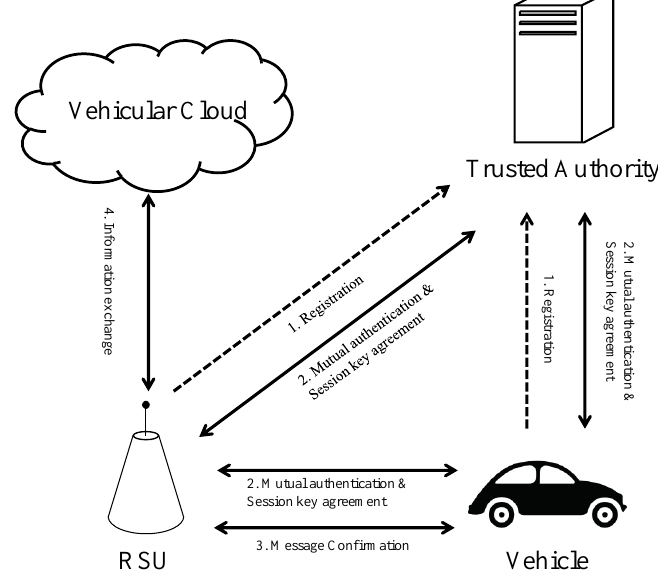
Figure 1. Proposed network